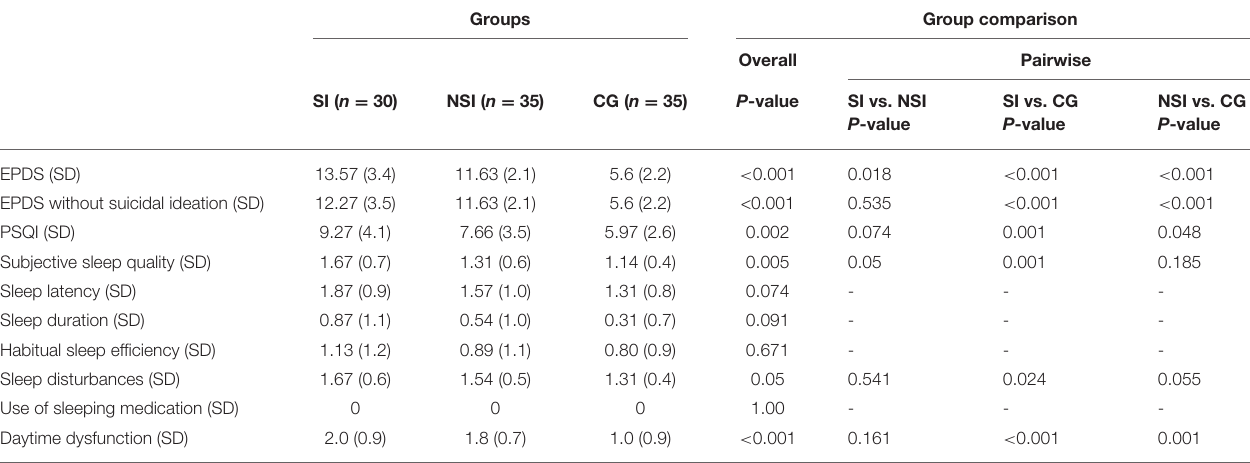
TABLE 2 | Differences in scores of PSQI and EPDS among the three groups (SI, NSI, CG). Groups Group comparison